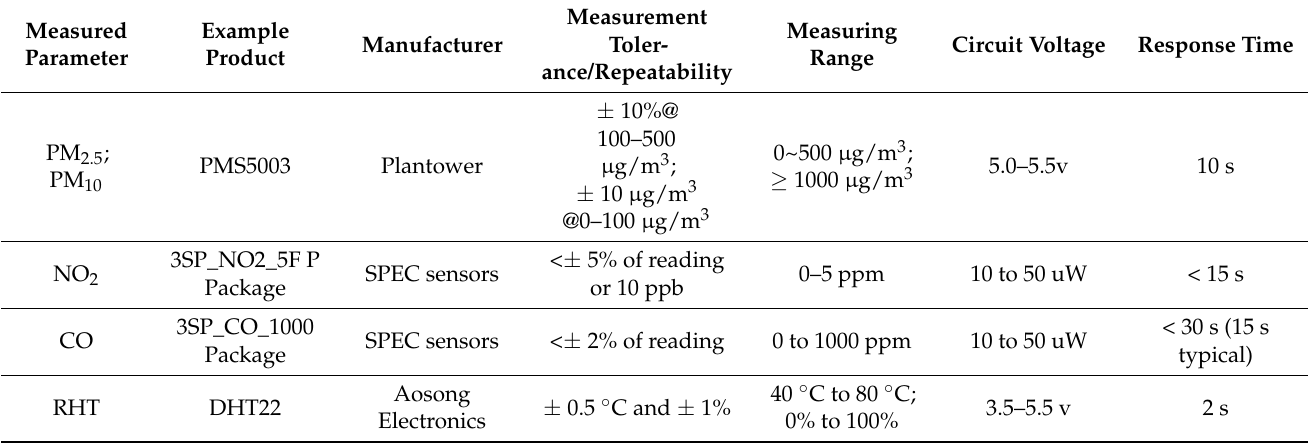
Table 2. Specifications of multi-sensor modules of Air Quality Egg version